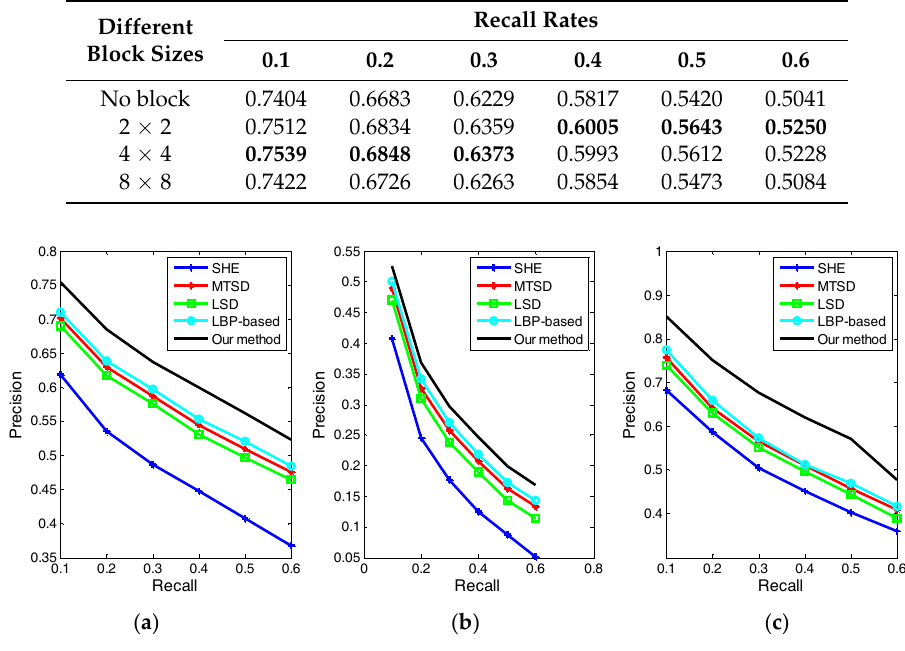
Figure 5. The comparison of average retrieval performance of different algorithms on different image databases: ( a ) Corel-1k; ( b ) Corel-10k; and ( c ) USPTex1.0.